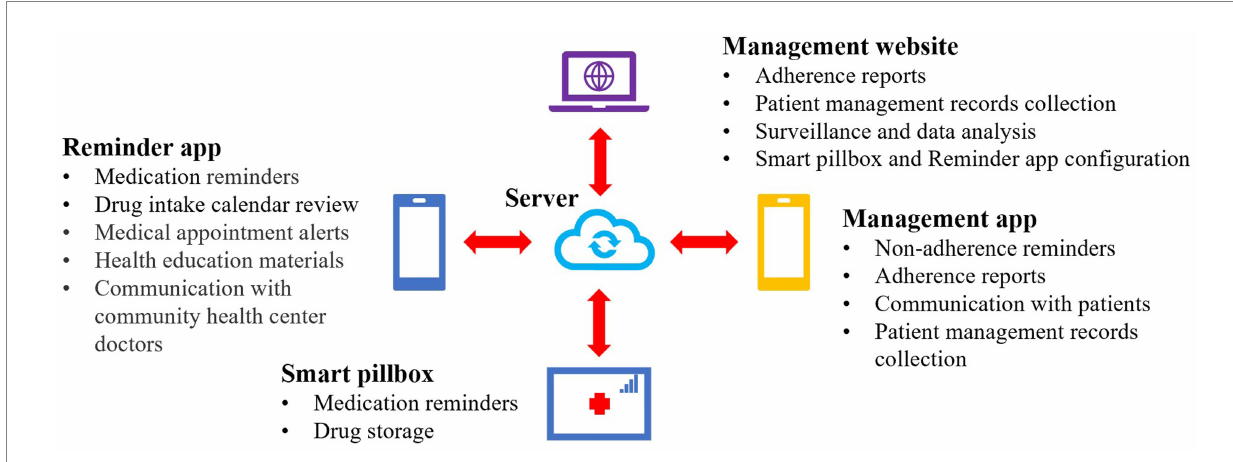
FIGURE 1 Schematic diagram for the mHealth reminder system. mHealth: mobile